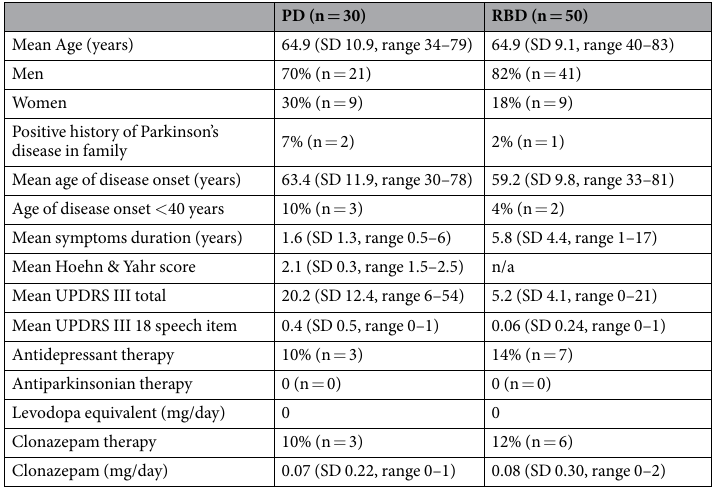
Table 1. Clinical characteristics of newly diagnosed, untreated PD patients and RBD subjects. Captions: PD = Parkinson’s disease, RBD = rapid eye movement sleep behaviour disorder, SD = standard deviation, n/a = not